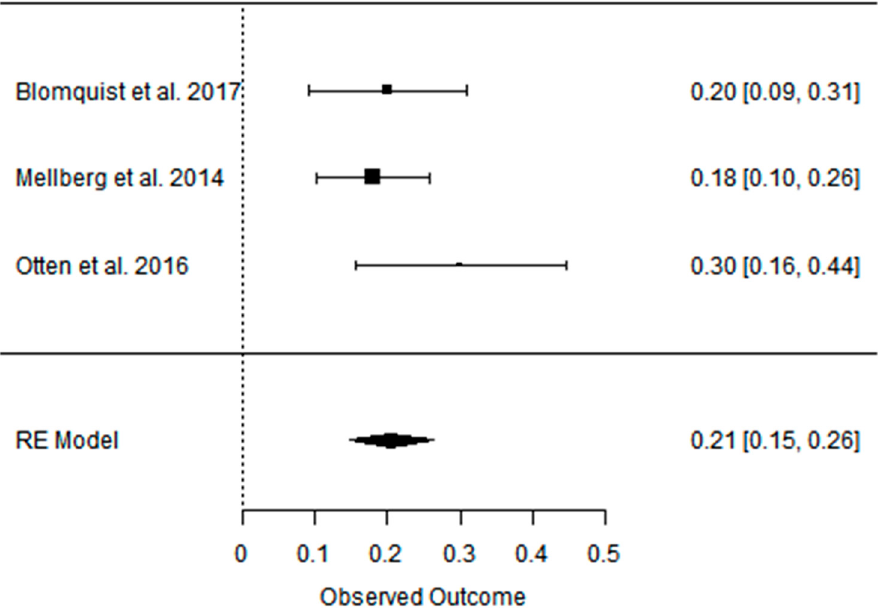
Figure A31. Forest plot of the effect of a CD on HDL-C in the long term (weighted mean difference).